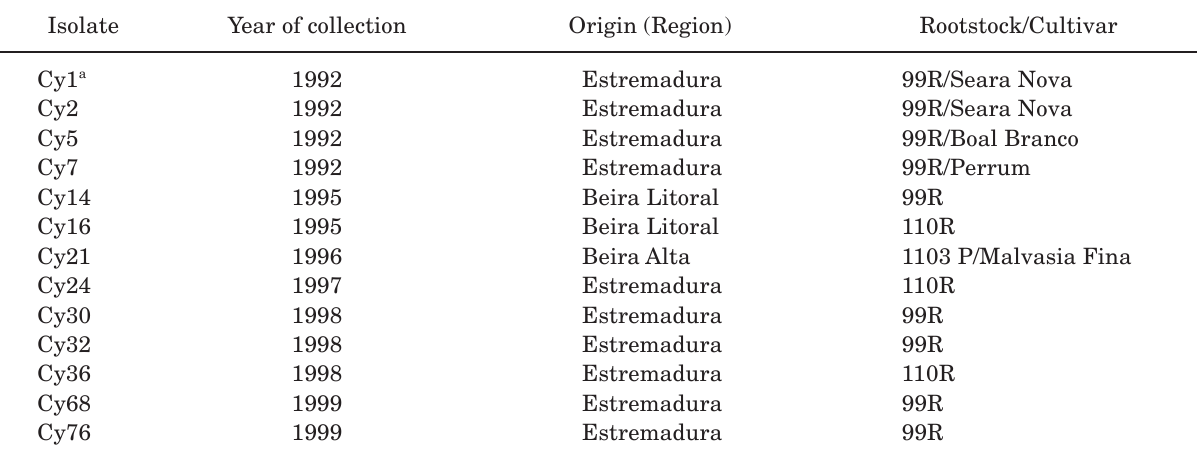
Table 1. Details of the Cylindrocarpon destructans isolates studied in this work.